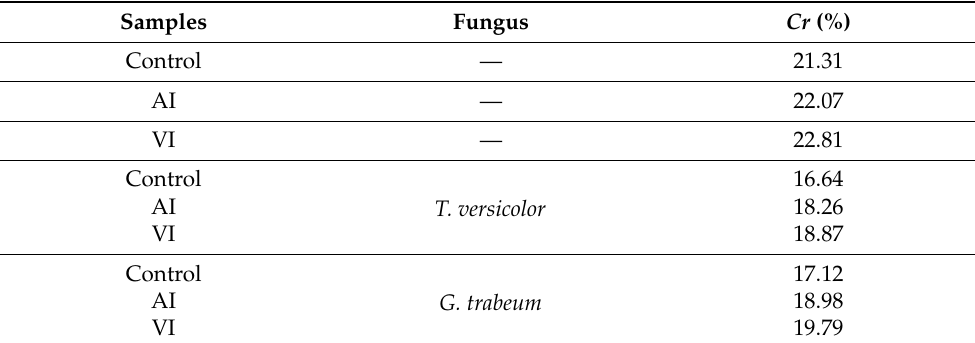
Table 2. Cr of untreated (control) and CuAz-treated (AI and VT) WFMRCs before and after 12 weeks of incubation with T. versicolor and G. trabeum